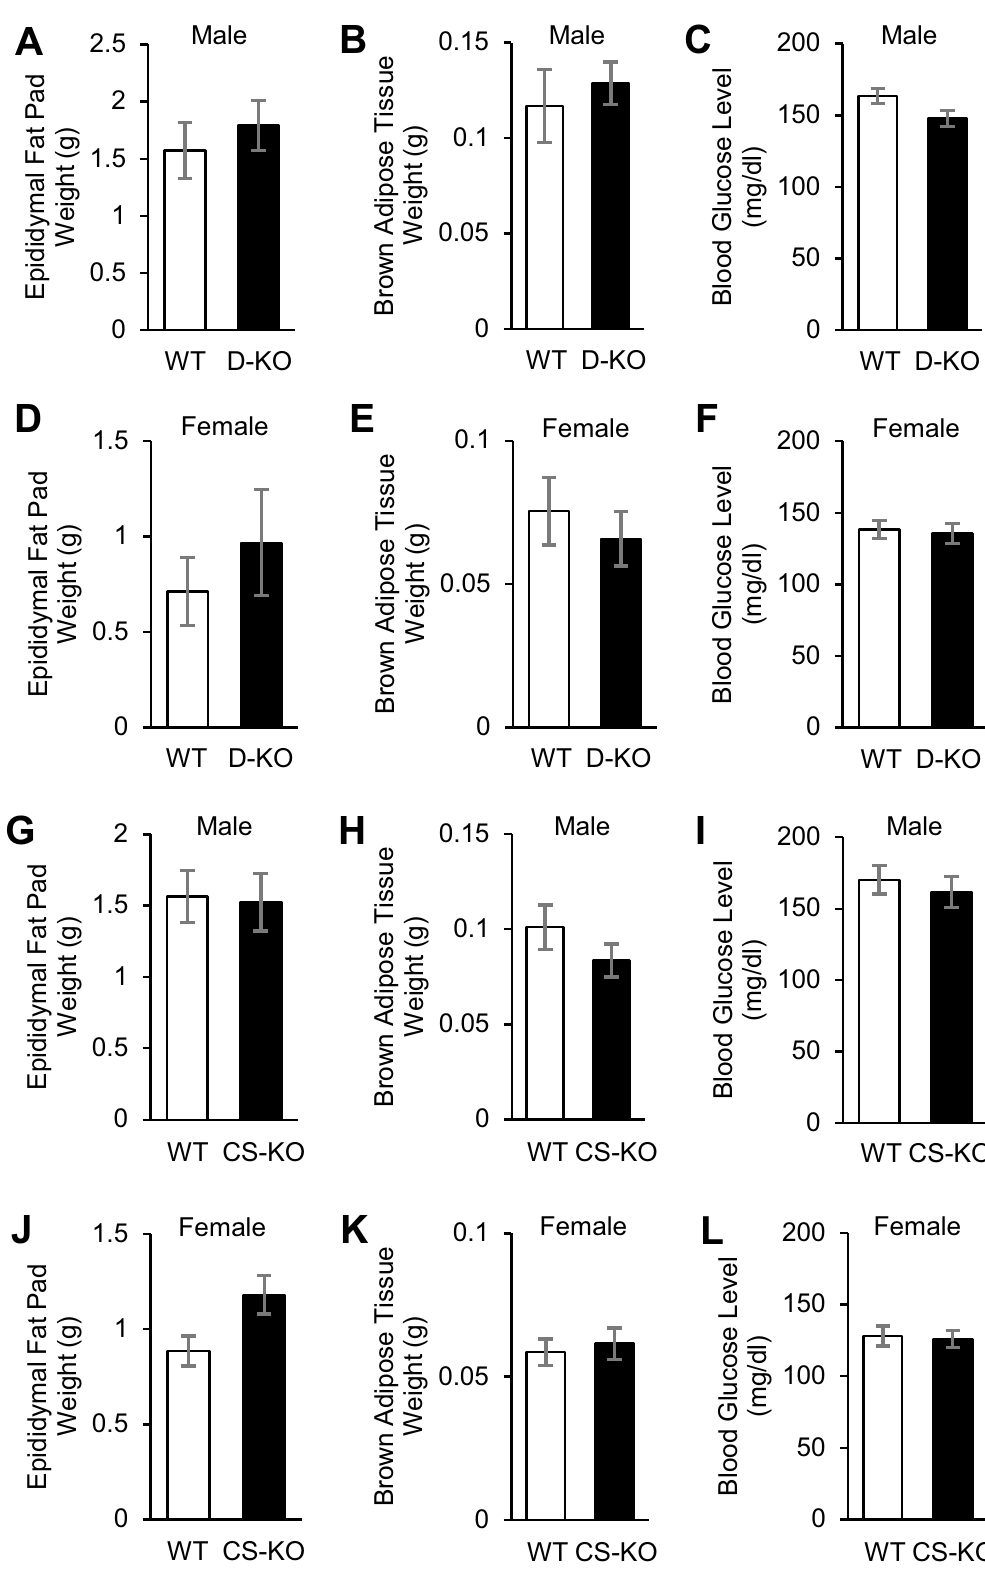
Figure 5. Body components and glucose metabolism were not affected by glucocorticoid receptor signaling in either dopaminergic neurons or corticostriatal neurons. ( A–F ) Epidydimal fat pad weights ( A , D ), brown adipose tissue weights ( B , E ), and blood glucose levels ( C , F ) of D-KO and WT mice at the age of 16 weeks ( A–C , males, n = 7–9 for each: D–F , females, n = 7–12 for each). No significant differences in those parameters were found in either male or female mice. ( G–L ) Epidydimal fat pad weights ( G , J ), brown adipose tissue weights ( H , K ), and blood glucose levels ( I , L ) of CS-KO and WT mice at the age of 16 weeks ( G-I , males, n = 9–11 for each: ( J–L ) females, n = 7–8 for each). No significant differences were found in those parameters in either male or female mice. All values are mean ± SEM. Statistical analyses were performed using unpaired t